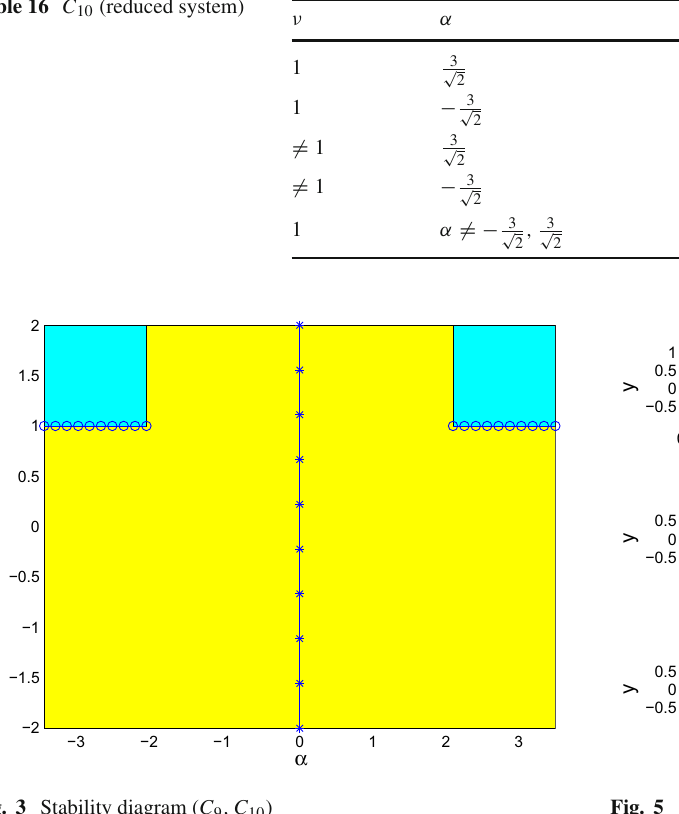
Fig. 3 Stability diagram ( C 9 , C 10 )